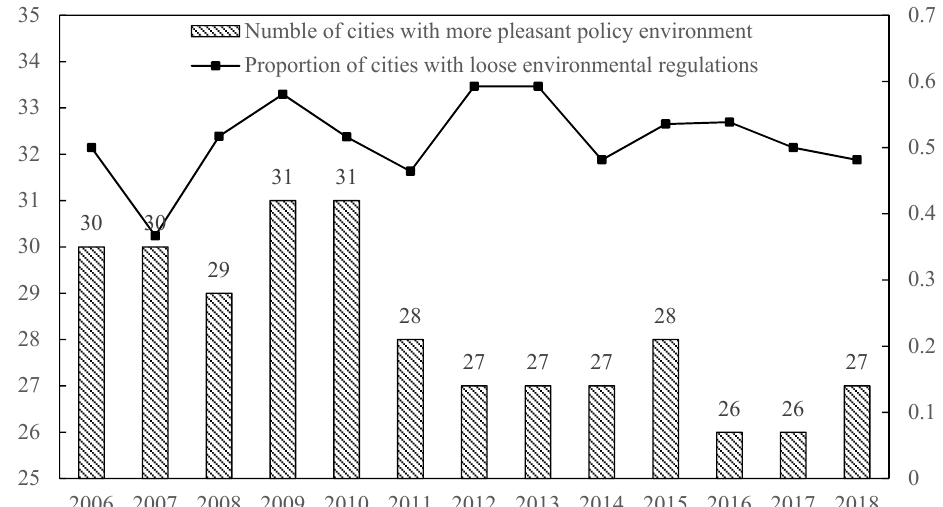
Figure 4. Number of cities with more pleasant policy environment. Note: Built by the authors based on the data calculated through the abovementioned method.